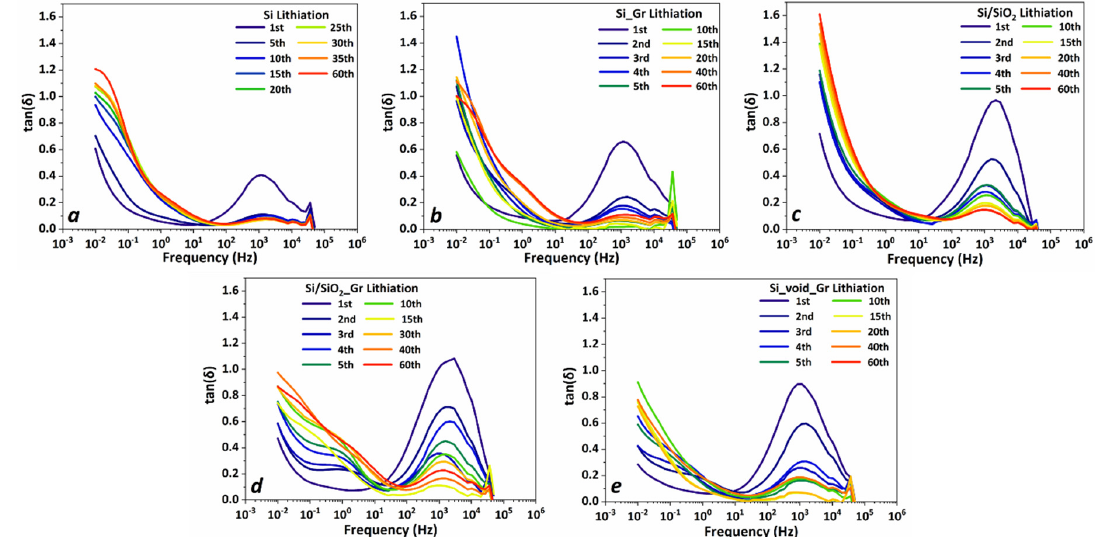
Figure 7. Loss tangent spectra, at the end of each lithiation cycle, for lithium half cells with cathodes of ( a ) Si, ( b ) Si_Gr, ( c ) Si/SiO 2 , ( d ) Si/SiO 2 _Gr, and ( e ) Si/void_Gr.